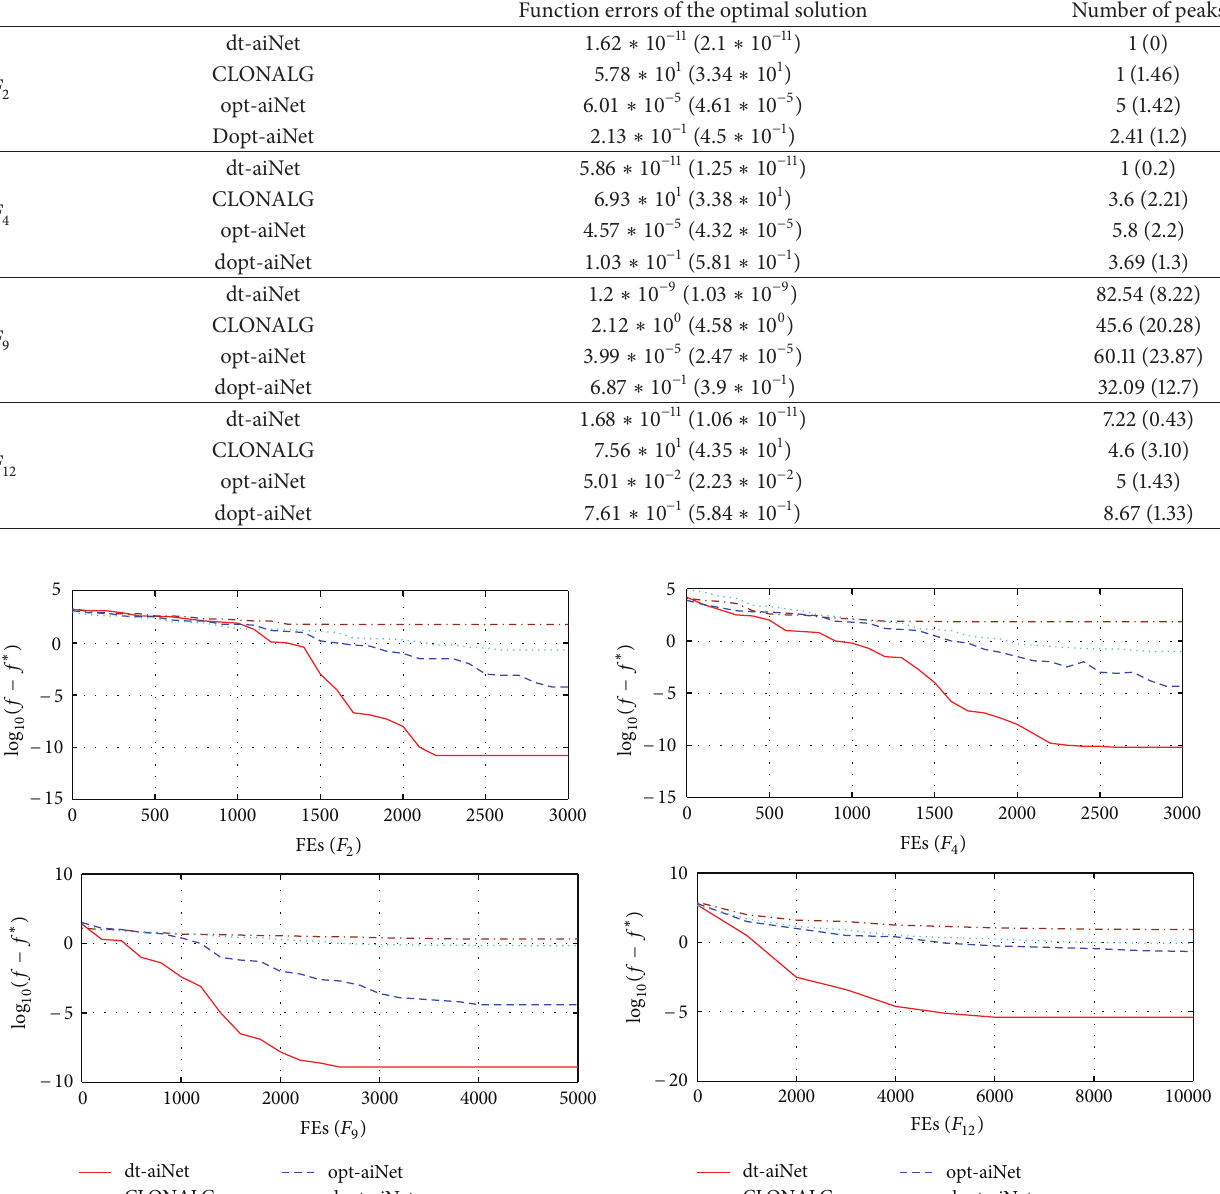
Table 3: Results (errors) in 2-dimensional spaces.